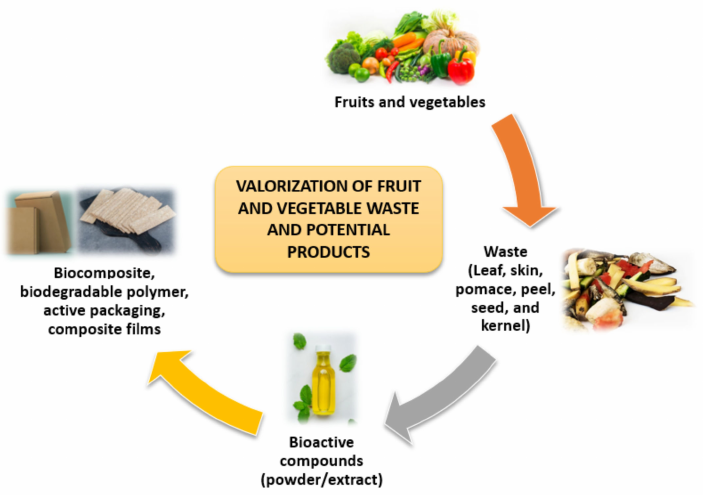
Figure 3. Valorization of FVW and potential